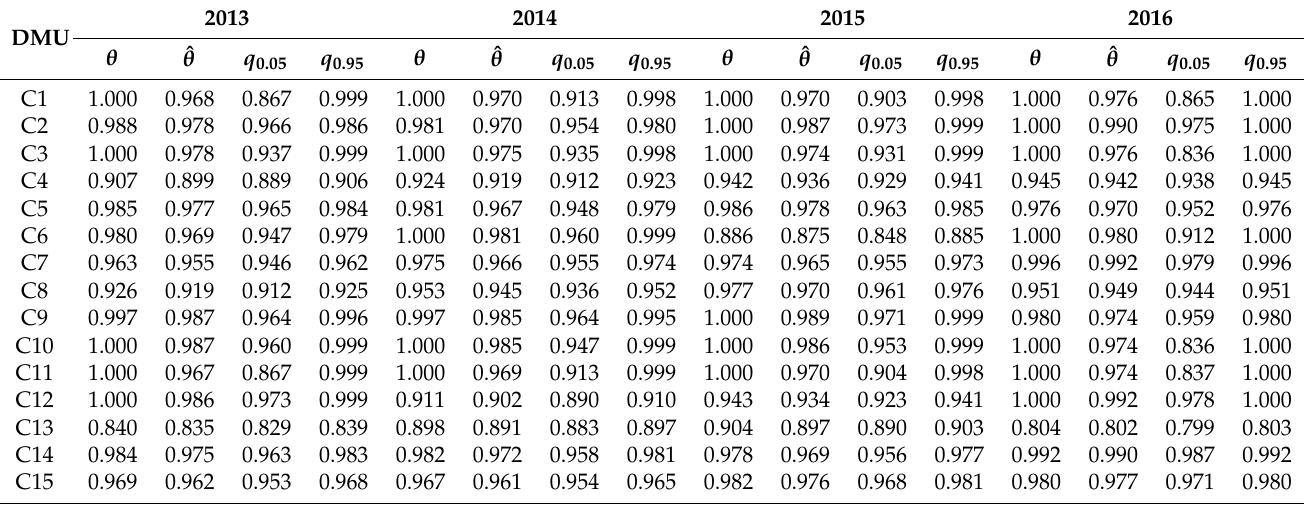
Table 4. Delivery dimension efficiencies, bias-corrected bootstrap efficiencies, and